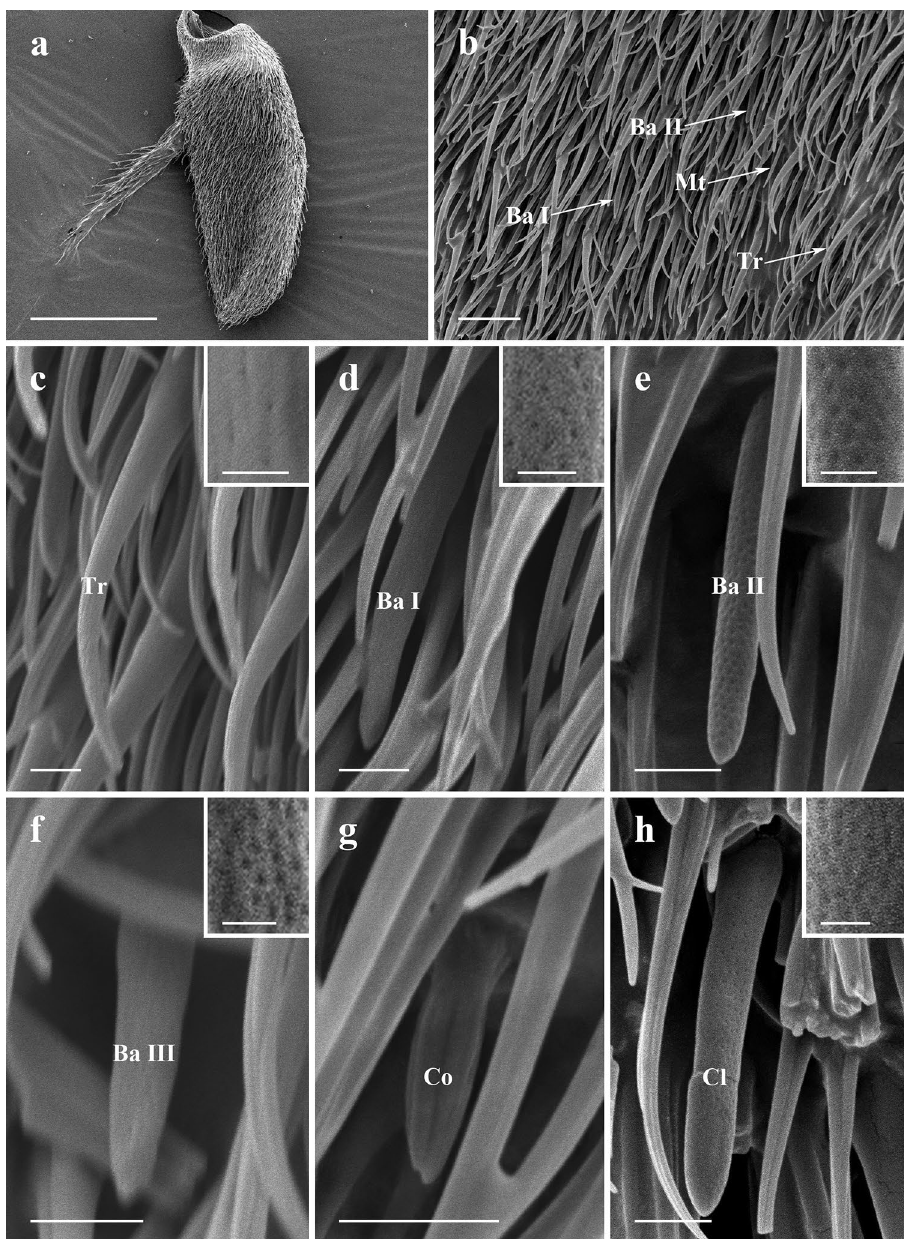
Figure 5. SEM micrographs of features on antennal postpedicel of male Lispe pygmaea . ( a ) Posterior surface of antennal postpedicel. ( b ) Distribution of different types of sensilla on antennal postpedicel. ( c ) Trichoid sensilla, box showing micropores on the surface. ( d ) Subtype I basiconic sensilla, box showing micropores on the surface. ( e ) Subtype II basiconic sensilla, box showing micropores on the surface. ( f ) Subtype III basiconic sensilla, box showing micropores on the surface. ( g ) Coeloconic sensilla. ( h ) Clavate sensilla, box showing micropores on the surface. Ba I subtype I basiconic sensilla, Ba II subtype II basiconic sensilla, Ba III subtype III basiconic sensilla, Co coeloconic sensilla, Cl clavate sensilla, Mt microtrichia, Tr trichoid sensilla. Scale bars: ( a ) 150 μm; ( b ) 10 μm; ( c–f,h ) 2.5 μm, 0.5 μm in box; (g) = 2.5